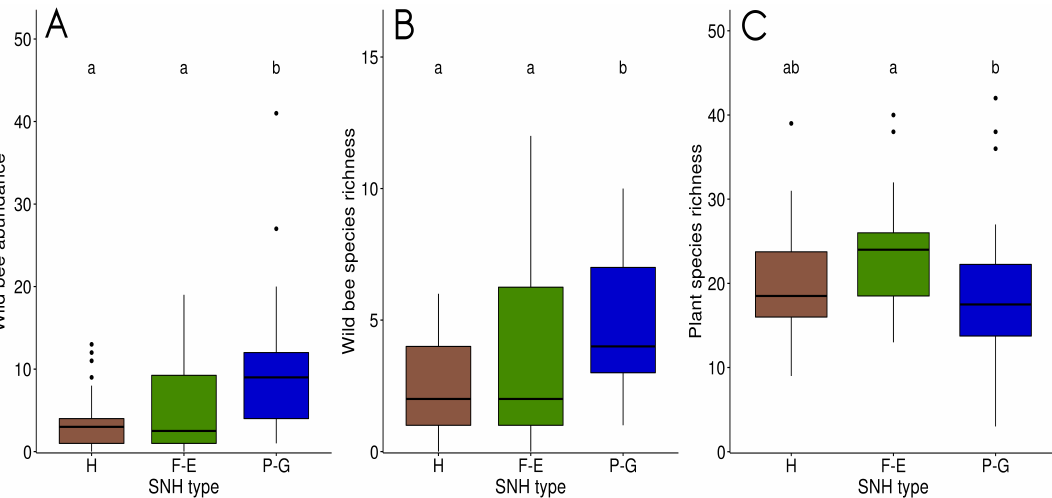
Figure 3. Bee abundance ( A ) and species richness ( B ), and plant species richness ( C ) in the sampling points of each semi-natural habitats (SNH) type (H: hedgerows, F-E: forest edges and P-G: permanent grasslands). The letters above each plot indicate significant differences between land cover types after multiple comparisons (Dunn’s test) following the Kruskal–Wallis (KW) test. Boxplots represent the median value, first and third quartile.